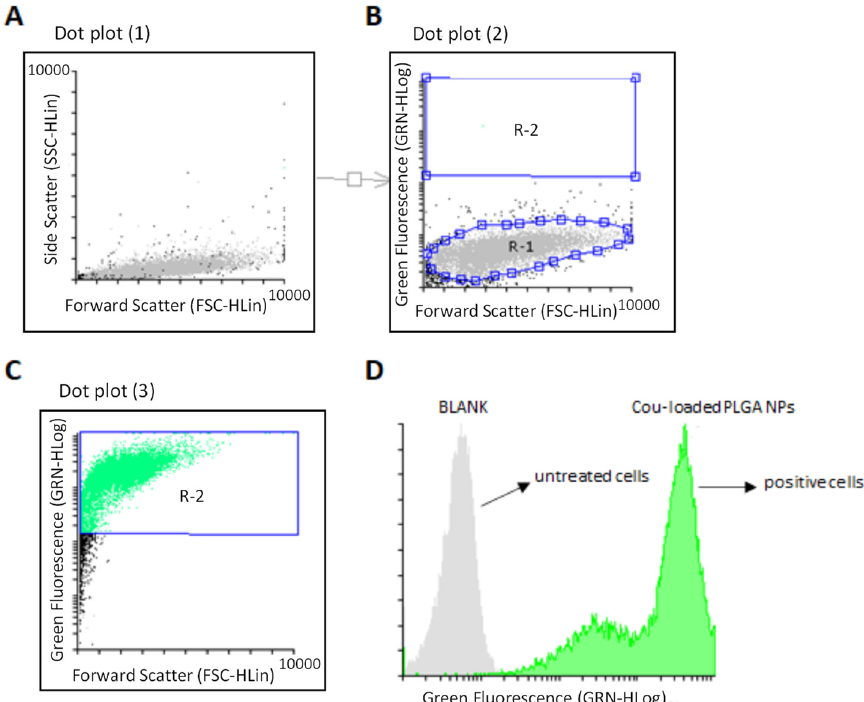
Figure 6. Flow cytometry analysis of Cou-labeled PLGA NPs in SH-SY5Y neuronal cells. ( A ): Normal cell population; ( B ): Selection of R1 and R2 gates for analysis; ( C ): Flow cytometry analysis for Cou-labeled PLGA NPs; ( D ): A flow cytometry histogram displays a shift among untreated cells and cell population containing Cou-labeled PLGA NPs. Transfection experiments were analyzed after 24 h incubation. A PLGA concentration of 0.23 mg · mL − 1 was used together with 0.01 mg · mL − 1 of Cou-6.